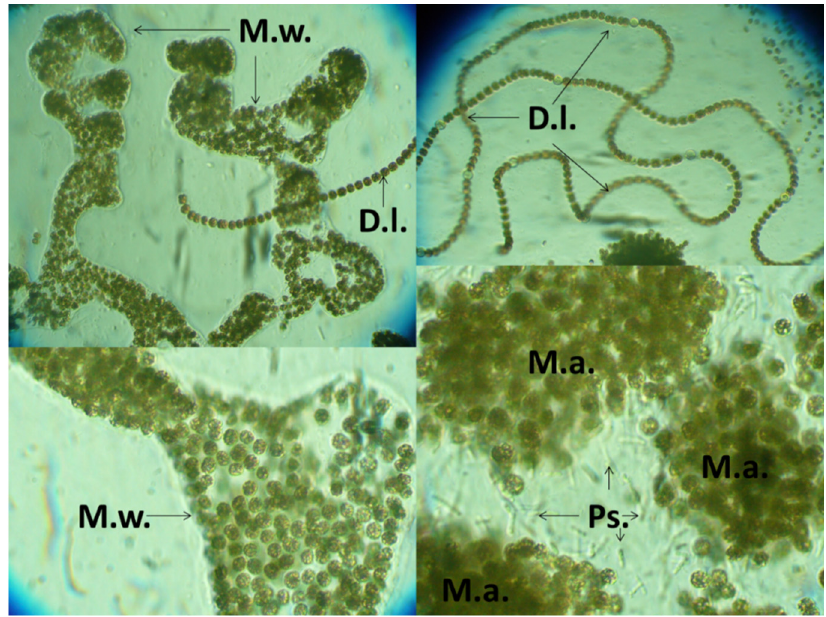
Figure 4. Microscopy pictures of dominant cyanobacteria in Lake Lesser Prespa (Greece) in summer 2012. M.w. = Microcystis wesenbergii , D.l. = Dolichospermum lemmermannii , M.a. = Microcystis aeruginosa , Ps. = Pseudanabaena –associated with the mucous of M. aeruginosa .